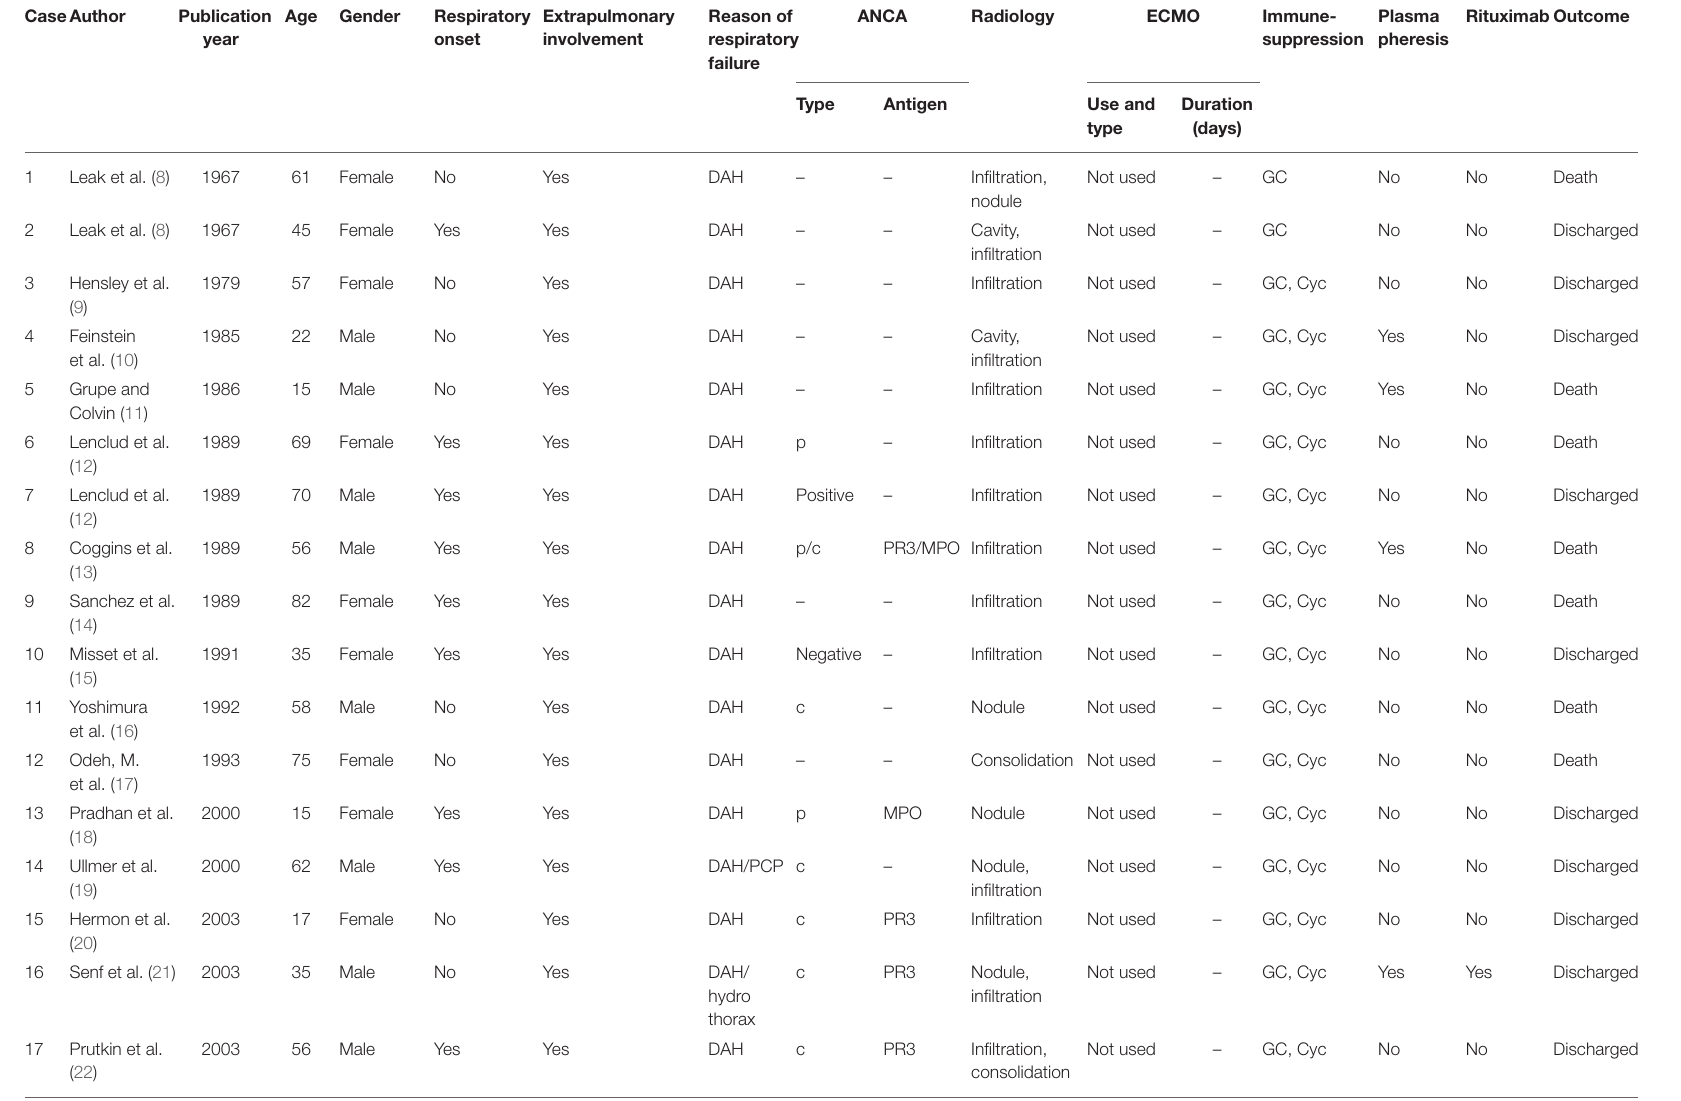
TABLE 2 | Case reports of respiratory failure due to granulomatosis with